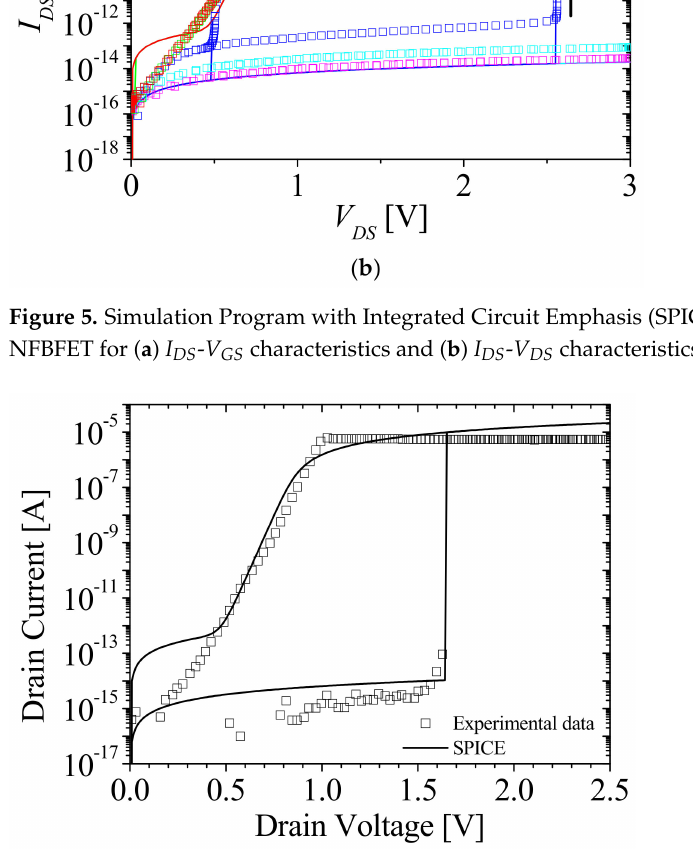
Figure 6. I DS – V DS characteristics: Symbols and lines denote experimental data and simulation results with the parameter extracted from experimental data [16],